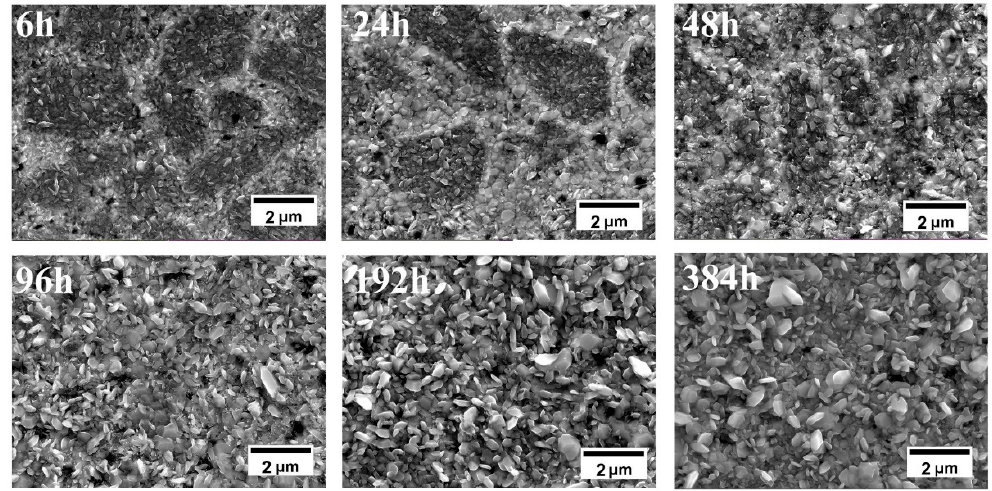
Figure 5. Surface morphology of the oxide scale after annealing at 600 °C for 6, 24, 48, 96, 192 and 384 h.